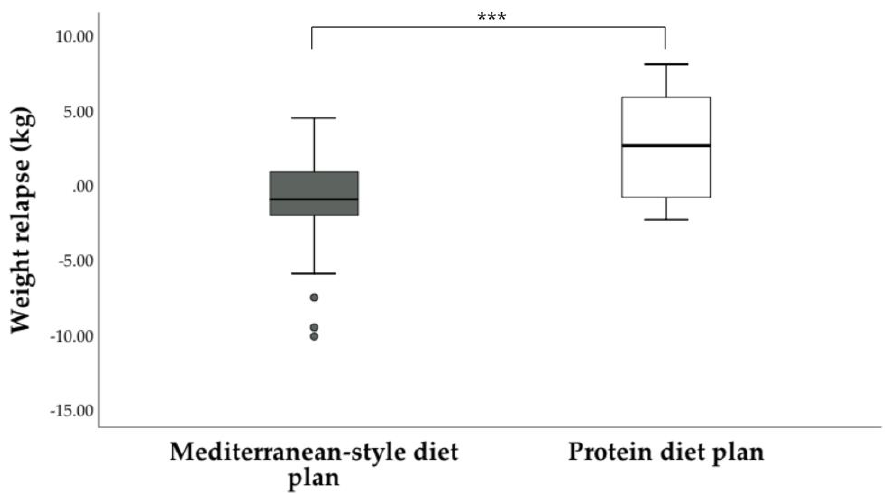
Figure 2. Weight relapse 3 months after completing the dietary intervention. General linear models adjusted for age, gender and type of EBT were used to compare weight relapse between groups. *** p < 0.001.